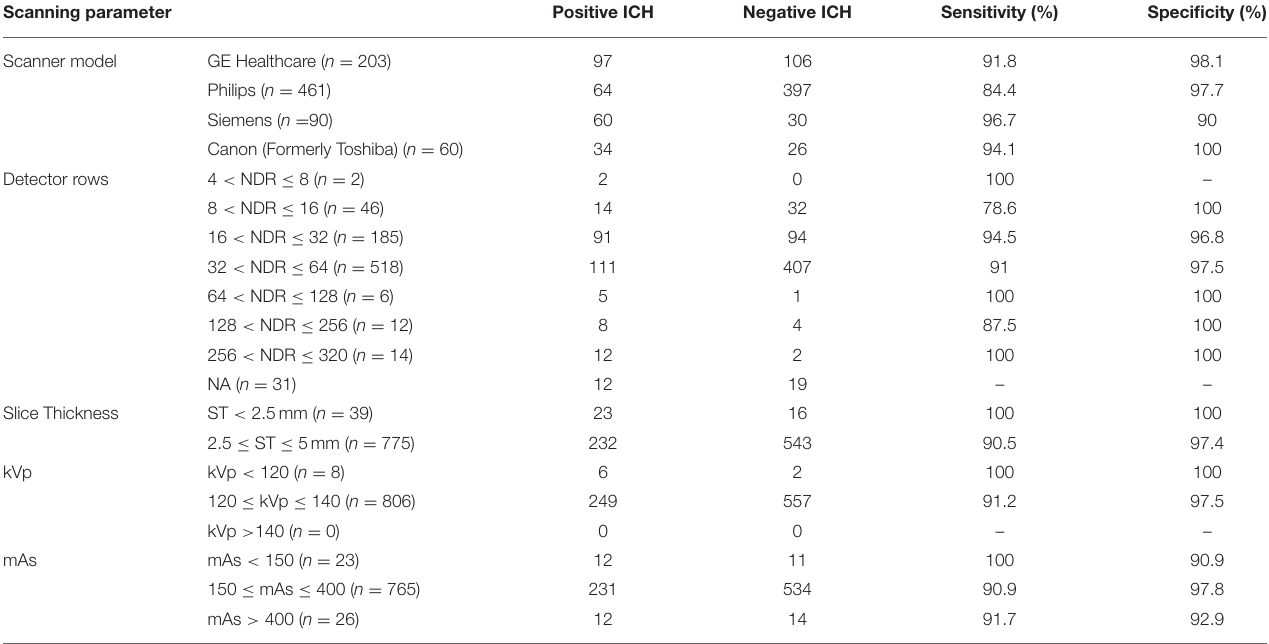
TABLE 5 | Performance metrics and distribution for ICH cases based on different scanning parameters. Scanning